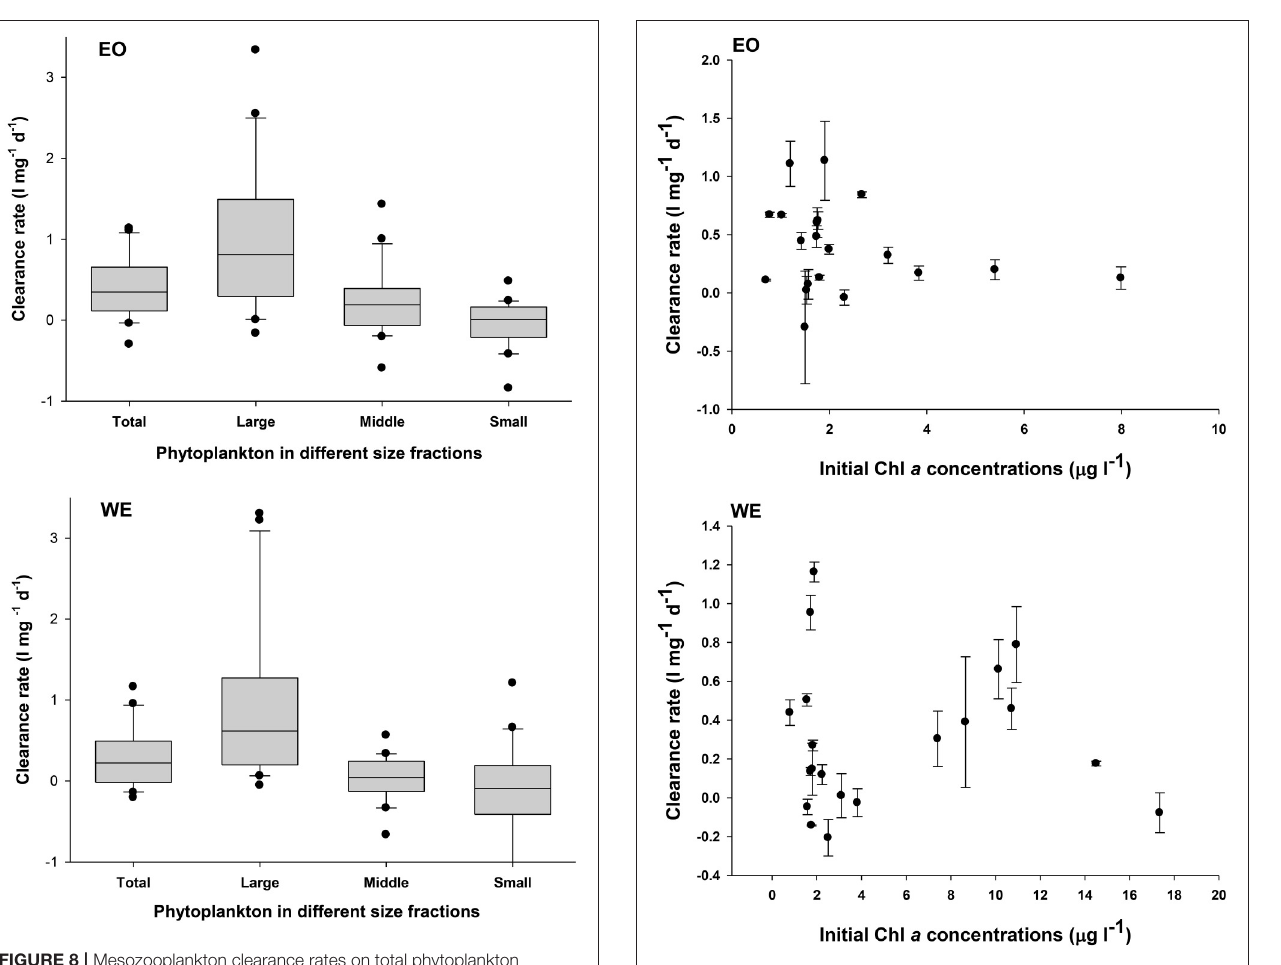
FIGURE 8 | Mesozooplankton clearance rates on total phytoplankton community (Total) and phytoplankton with different sizes (Large: > 20 µ m; Middle: 2 ∼ 20 µ m and 5 ∼ 20 µ m in the first and the second sampling year, respectively; Small: < 2 and < 5 µ m in the first and the second sampling year, respectively) at the two stations EO and WE. Data are expressed as median (horizontal bar) with 25th–75th (box) and 10th–90th (whiskers) percentiles.